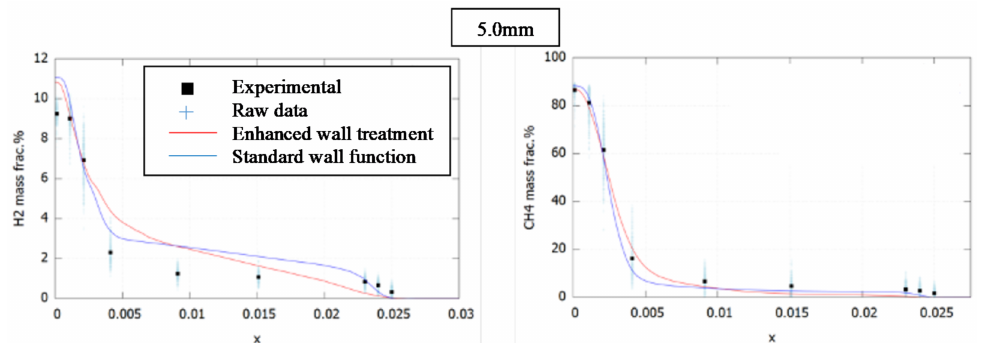
Figure 16. Fuel species mass fraction profiles at increasing axial distances. FGM/CRECK. Complete experimental data available at reference